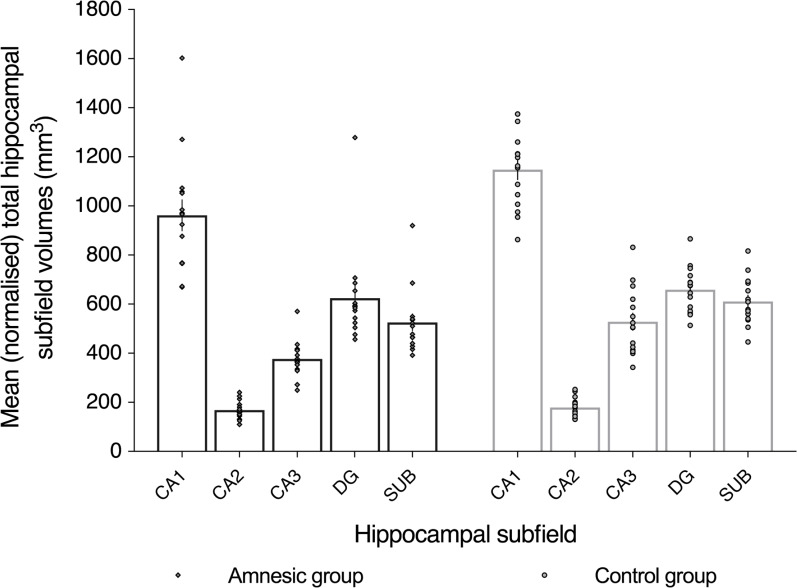
Plot of mean (normalized) total hippocampal subfield volumes (mm3) for participants in the amnesic group and control group.All subfield volumes were normalized to the total intracranial volumes obtained from the voxel-based morphometry (VBM) analyses. Volumes were collapsed across the left and right hippocampi because there was no significant interaction between group (amnesic, control), side (left, right), and subfield (CA1, CA2, CA3, DG, and SUB) (F(2.02,56.55) = 0.43, p=0.66, η2p = 0.015; Figure 2). CA3 volume was reduced in the amnesic group relative to the control group (F(1,28) = 14.52, p=0.001, Cohen’s d = 1.39; mean reduction = –29%). Volume loss in CA1 was not significant (mean volume loss = -16%, F(1,28) = 5.25, p-uncorrected = 0.019, Cohen’s d = 0.91), when the alpha criterion was Holm-Bonferroni corrected for multiple comparisons. All other subfields were non-significant at the alpha criterion corrected for multiple comparisons. Insufficient contrast for delineation between the subfield boundaries on each coronal slice precluded hippocampal subfield segmentation of one participant who was included in the results from the Autobiographical Interview (AI). Horizontal lines correspond to the mean of each total subfield volume and the corresponding error bars depict the ± standard errors of the mean (s.e.m.). CA1 = cornu ammonis 1, CA2 = cornu ammonis 2, CA3 = cornu ammonis 3, DG = dentate gyrus, and SUB = subiculum. Individual data points are shown as a gray diamond for an amnesic group participant and as a gray circle for a control group participant.